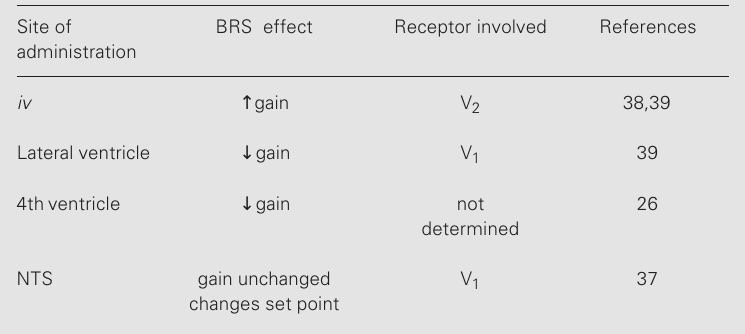
Table 1 - Vasopressin effects on baroreceptor reflex (BRS) control of heart rate in conscious rats. NTS, Nucleus tractus